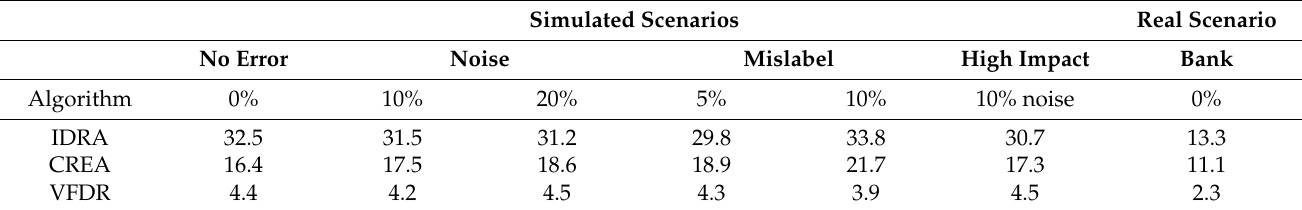
Table 4. Mean time (in seconds) of the three algorithms.